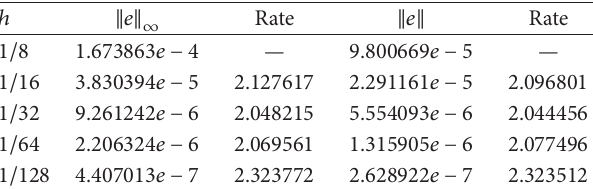
Table 6: The errors of numerical solutions at 𝑡 = 10 , 𝜏 = 0.1 , 𝛽 = 1 , 𝛼 = 2 , and 𝑝 = 8 .